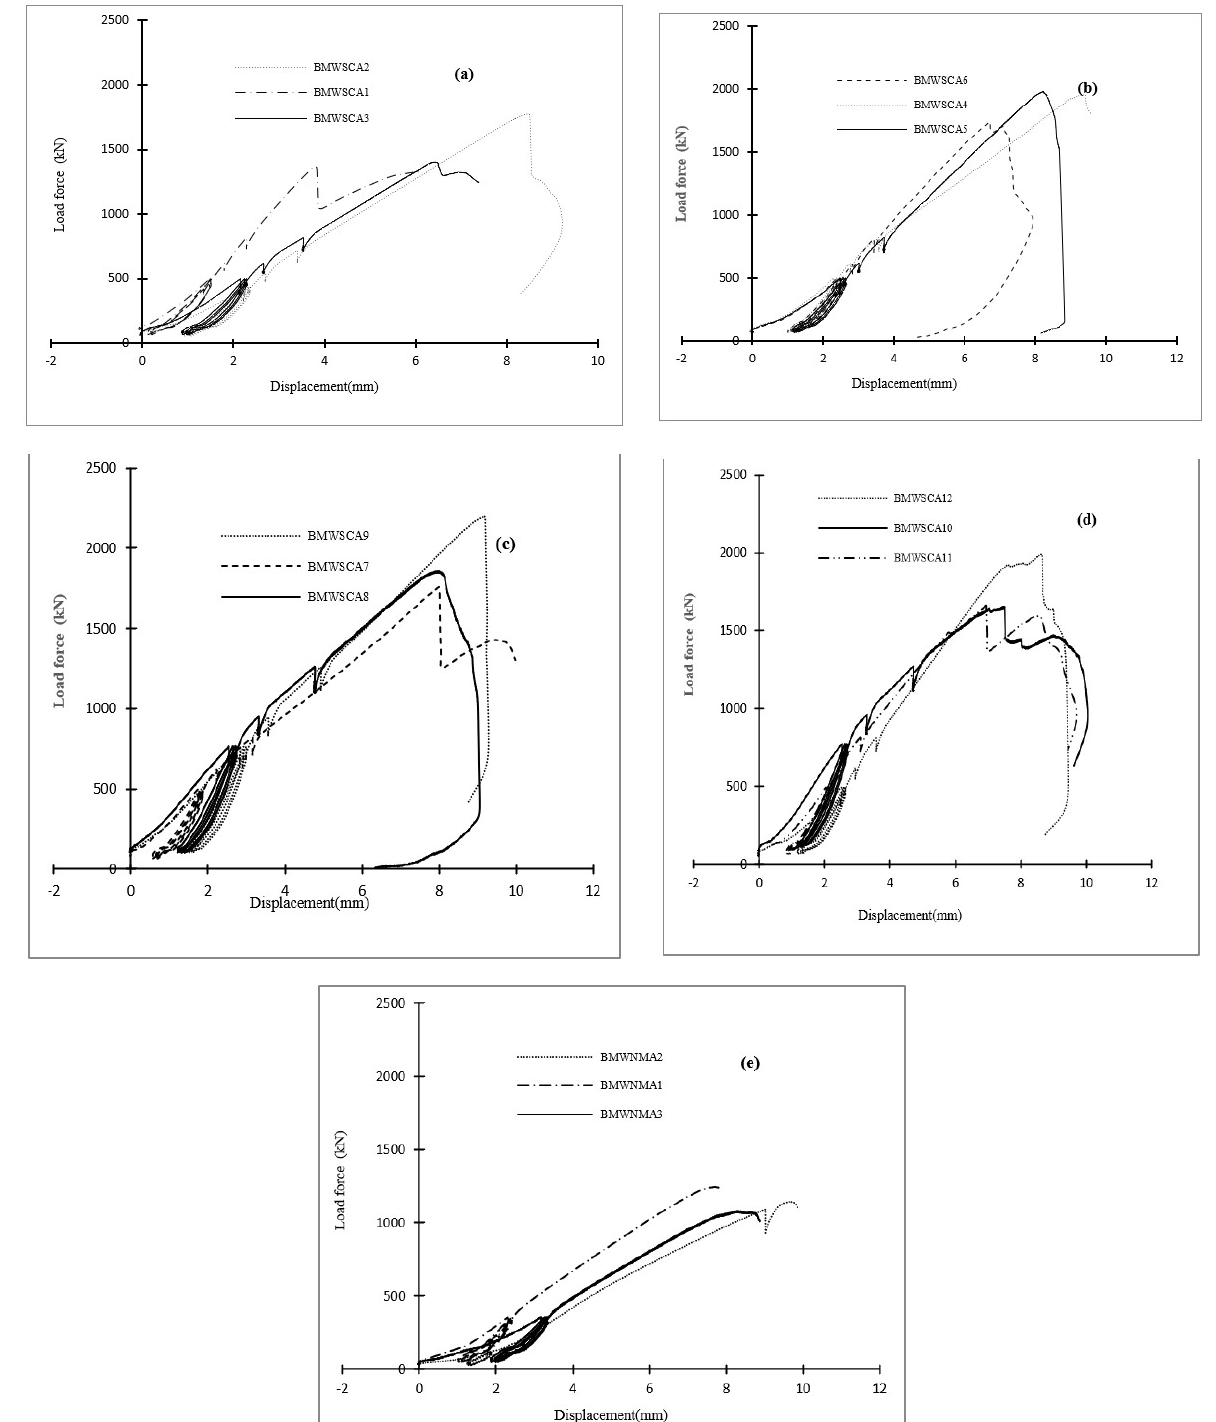
Figure 7. Force-displacement curves in masonry samples: ( a ) Sample with single-sided 30 mm thickness of sprayed layer; ( b ) Sample with single-sided 40 mm thickness of sprayed layer; ( c ) Sample with single-sided 50 mm thickness of sprayed layer; ( d ) Sample with double-sided 30 mm thickness of sprayed layer; and ( e ) Sample without the sprayed layer